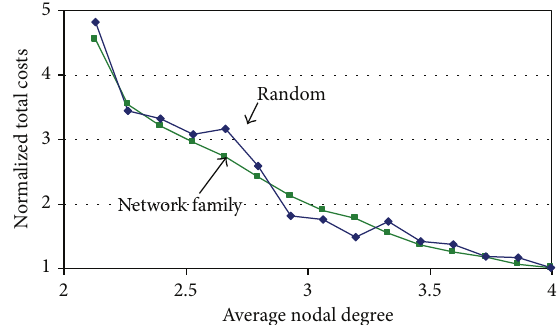
Figure 12: Normalized p -cycle JCA total capacity costs for a random subset of networks compared to the network family.